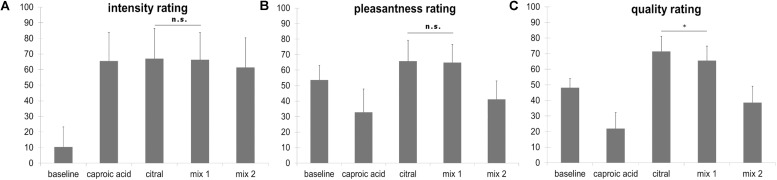
(A) Intensity ratings ranging from “not perceivable” (coded with 0) to “very strongly perceivable” (coded with 100), mix 1: fully masked stimulus, mix 2: incompletely masked stimulus. (B) Pleasantness ratings ranging from “very unpleasant” (coded with 0) to “very pleasant” (coded with 100), mix 1: fully masked stimulus, mix 2: incompletely masked stimulus. (C) Quality ratings ranging from 100% goat (caproic acid, coded with 0) to 100% lemon (citral, coded with 100), participants were instructed to rate the baseline stimulus (odorless PG) with the middle marker (coded with 50) on the scale. mix 1: fully masked stimulus, mix 2: incompletely masked stimulus. All comparisons for the quality rating yield a statistically significant difference, however, in this figure only the comparison citral vs mix 1 is depicted (∗p < 0.05). Error bars display standard deviations. The stimulus “caproic acid” was not presented in the fMRI task.